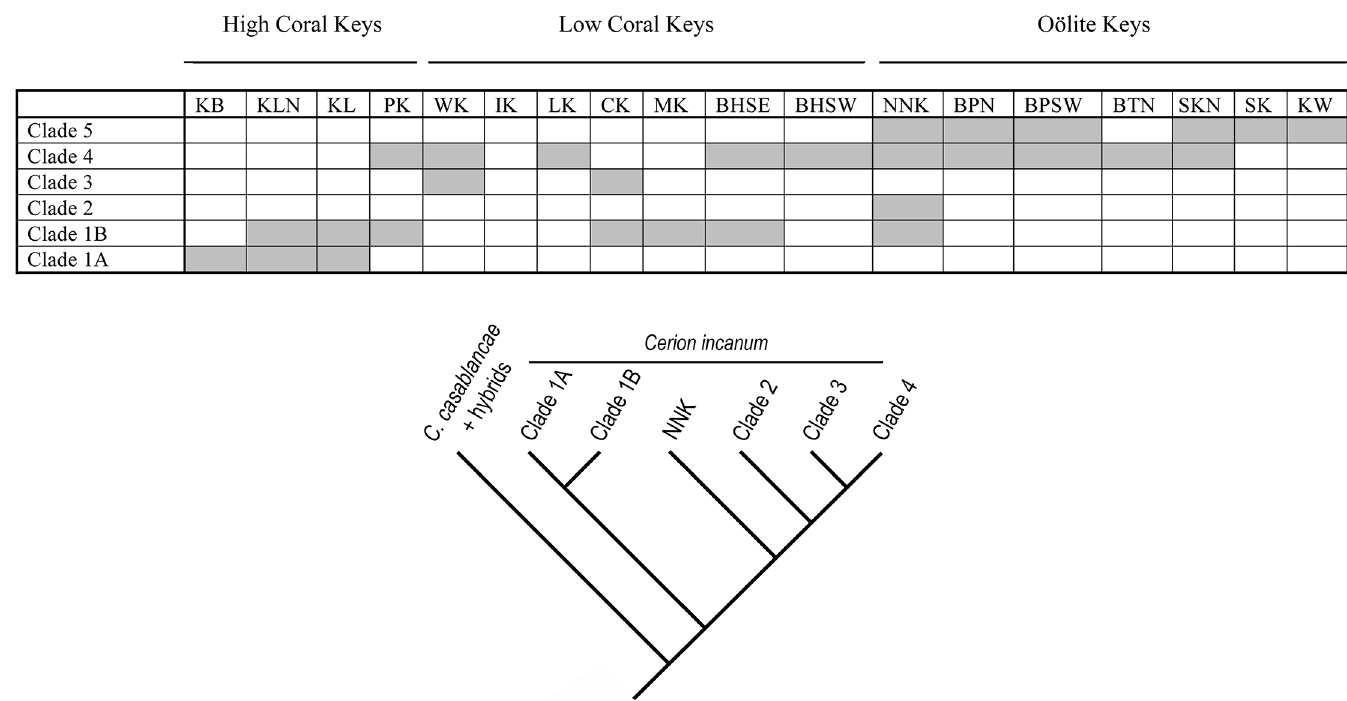
Fig 5. Geographic distribution of haplotypes present in the major clades of Cerion incanum in the Florida Keys identified in Fig 4.